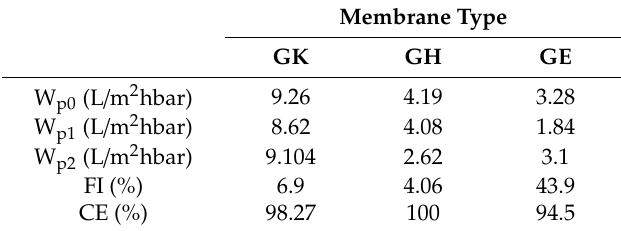
Table 2. Water permeabilities, fouling index and cleaning e ffi ciency of selected UF membranes.